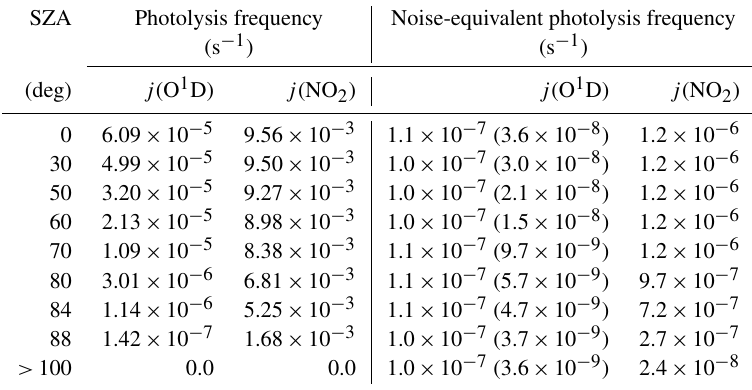
Table 5. Photolysis frequencies calculated from the actinic flux density spectra of Table 4 (left) and simulated noise-equivalent photolysis frequencies of instrument 62001 for a maximum 300ms integration time (right). The j (O 1 D) precisions in brackets were obtained by applying variable cutoff wavelengths (Fig. 12). The entry SZA > 100 ◦ indicates dark conditions with zero spectral actinic flux